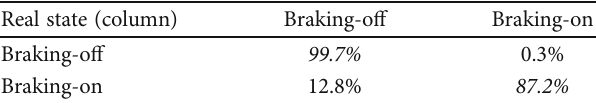
Figure 8: The curve of Ω c ,max for a testing sequence. The horizontal axis is the frame number and the vertical axis denotes the value of . Table 2: Brake-light signal measurement